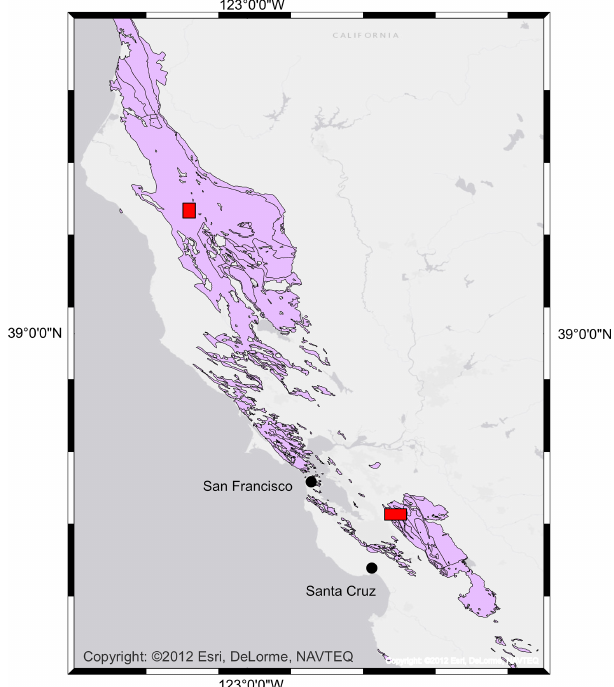
Figure 1. Overview of the study region. Franciscan Complex rocks are shown in purple. Red boxes indicate the locations of the two field locales.